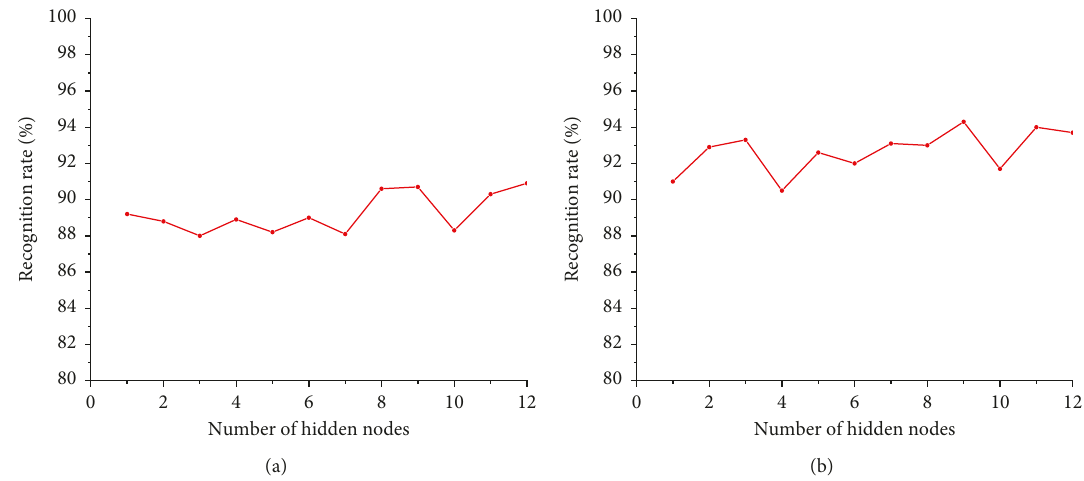
Figure 7: The recognition rate of the number of nodes in each hidden layer of the neural network. (a) Recognition rate of fist movement. (b) Recognition rate of palm